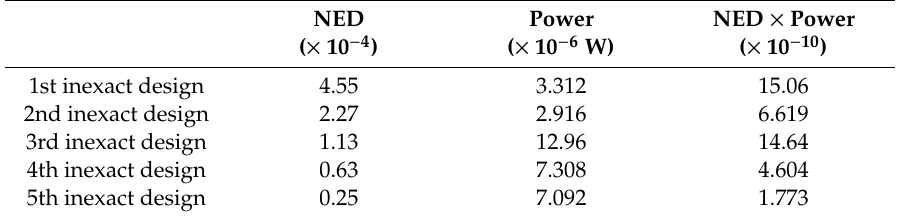
Table 7. Normalized error distance (NED) and Power Comparison.